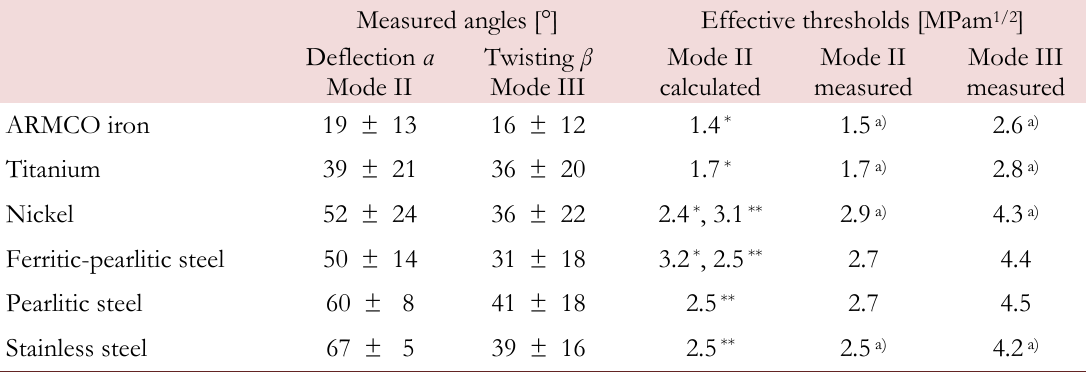
Table 1: Summary of the experimentally obtained values of deflection angles of mode II loaded cracks, twist angles of mode III loaded cracks and the effective thresholds in mode II and mode III for 6 metallic materials. Effective mode II thresholds calculated using Eq. (1) is shown for comparison. For materials with a large local mode I component the values according to Eq. (2) are shown. Fracture surfaces were reconstructed in 3D using the stereophotogrammetry in the scanning electron microscope (SEM) [5]. Quantification of the 3D data was done by a profile analysis – see Figs. 2 – 5. The coordinate l passes along the